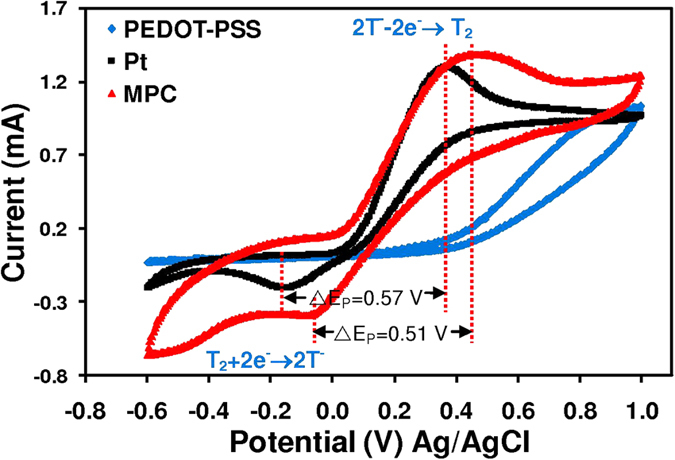
Cyclic voltammogram (CV) curves of mangosteen peel carbon (MPC), PEDOT-PSS and Pt electrodes at a scan rate of 20 mV/s in 10 mM NMe4 + T−, 1 mM T2 and 0.1 M LiClO4 in an acetonitrile solution.